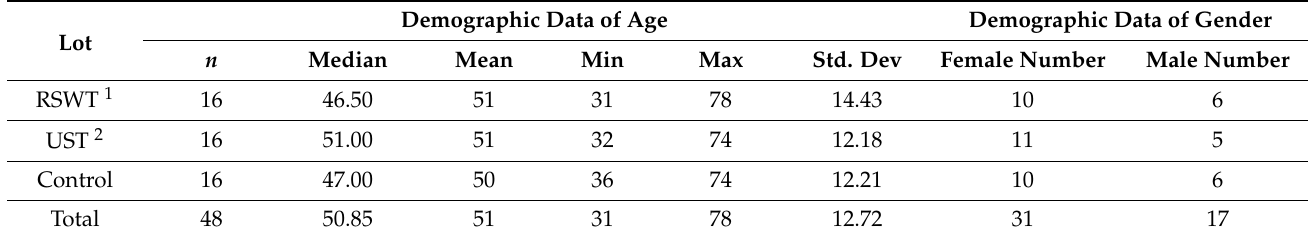
Table 2. Demographic data of age and gender.